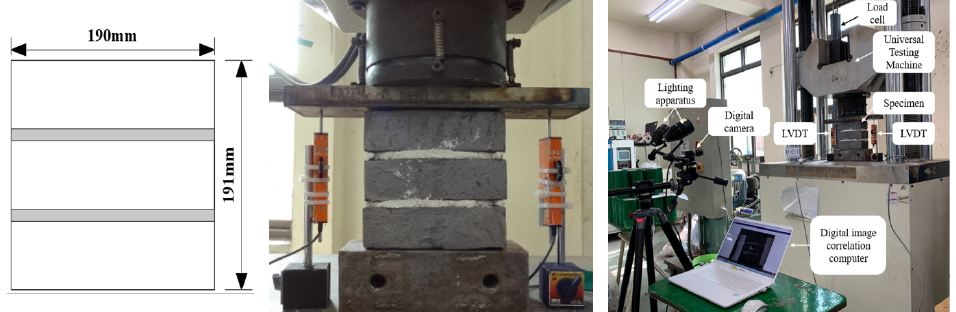
Figure 6. Experimental setups for compression test.